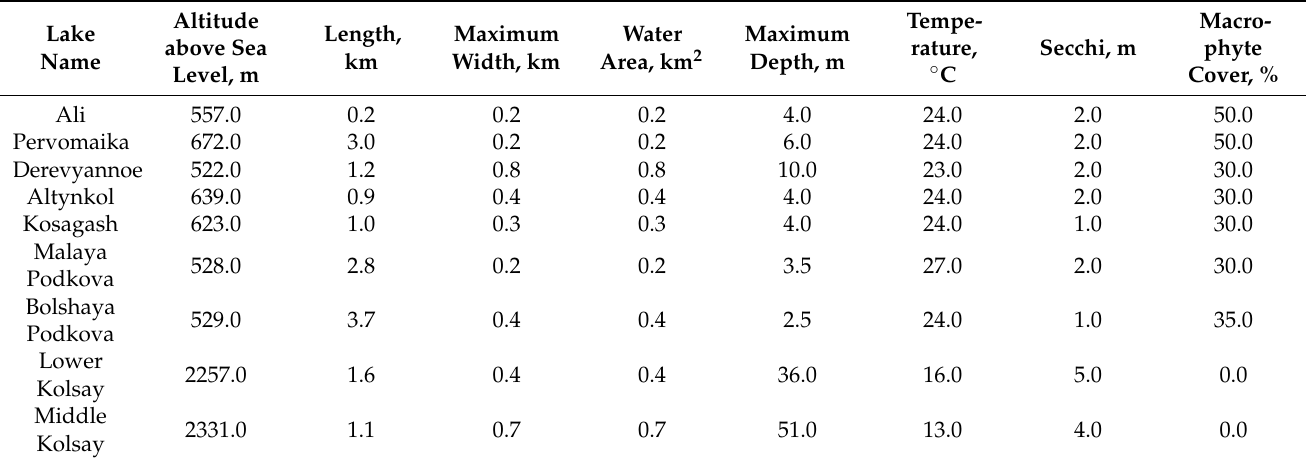
ency was determined using a Secchi disk. Macrophyte cover was assessed visually.